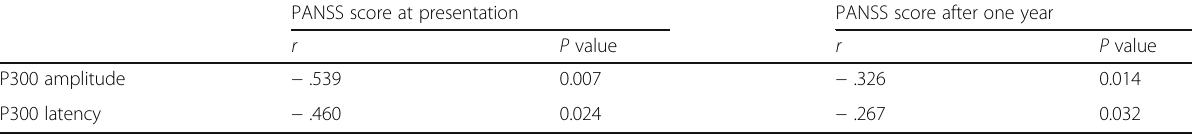
Table 6 Correlation between PANSS scores and P300 amplitude and latency PANSS score at